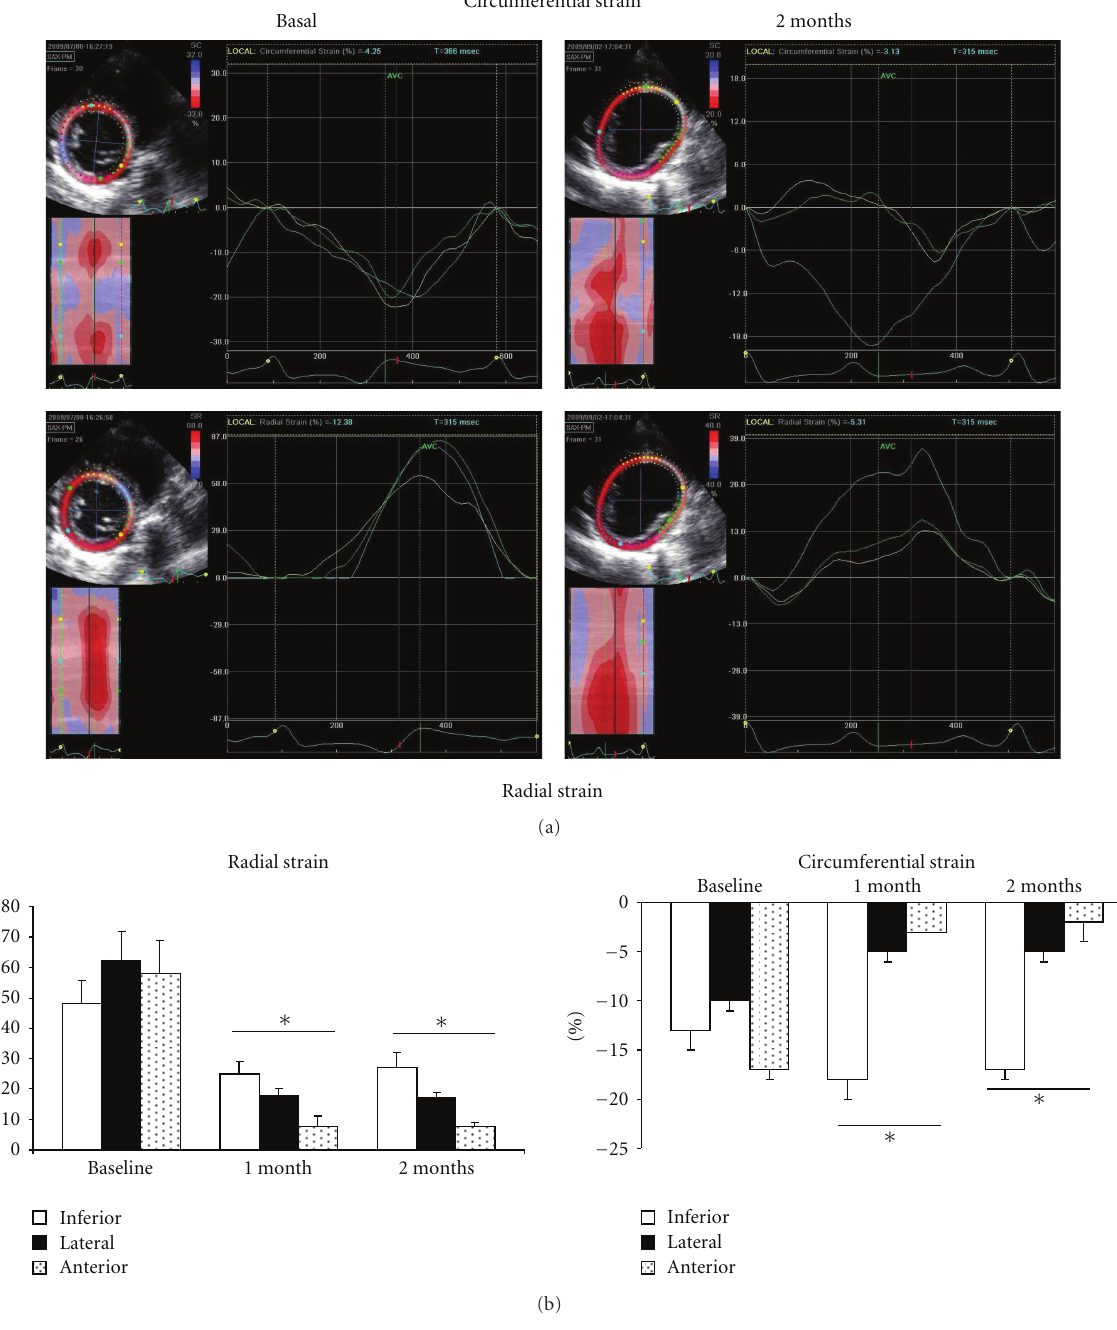
Figure 5: (a) Echocardiographic visualisation of the development of radial and circumferential deformation in healthy and ischemic zones. Quantification of peaks in circumferential and radial strain in ischemic and control areas showed substantial anomalies in radial and circumferential deformations alike, both on the anterior and lateral surface of the heart, with compensation marks on the inferior healthy surface ( ∗ P < . 01 compared to basal time). (b) Graphic representations of anomalies in radial and circumferential deformation in walls of